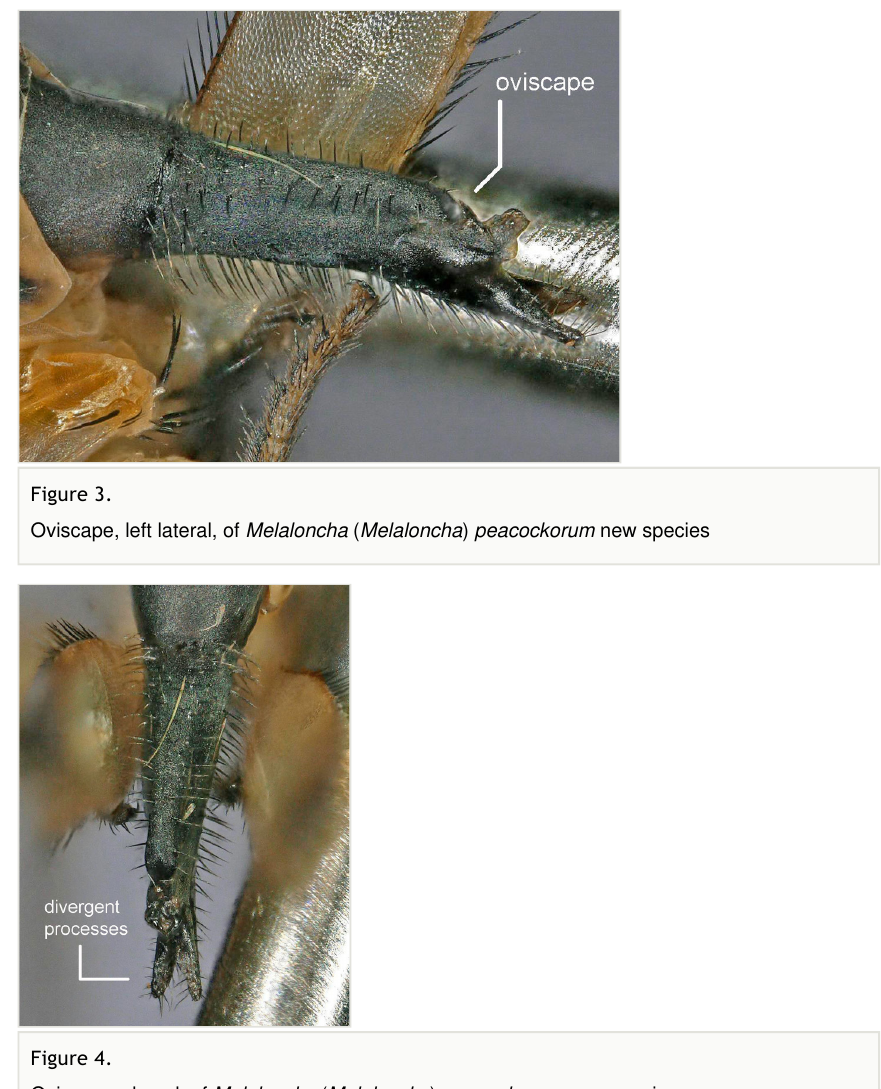
Diagnosis Dark colored Melaloncha ( Melaloncha ) with wide, orange, punctate frons, and oviscape with blunt, dorsal, median lobe plus more ventral, bifurcate lobe. In the most recent key to Melaloncha ( Melaloncha ) species (Brown 2006), M. peacockorum does not successfully pass couplets 5 to 6, which should be modified as follows: